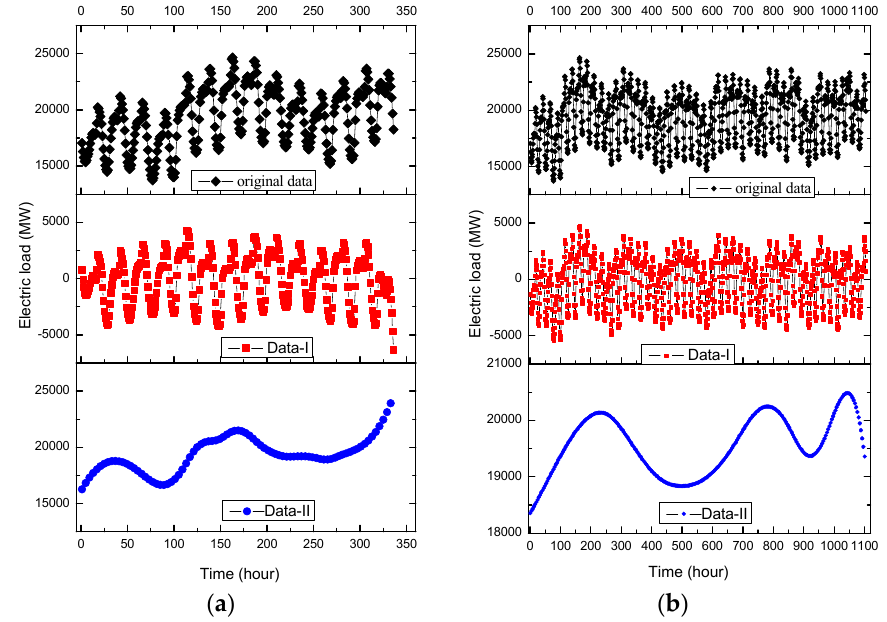
Figure 9. The hour based original data, Data-I, Data-II (Example 2). ( a ) Small data size (1–14 January 2015); ( b ) Large data size (1 January–15 February 2015).